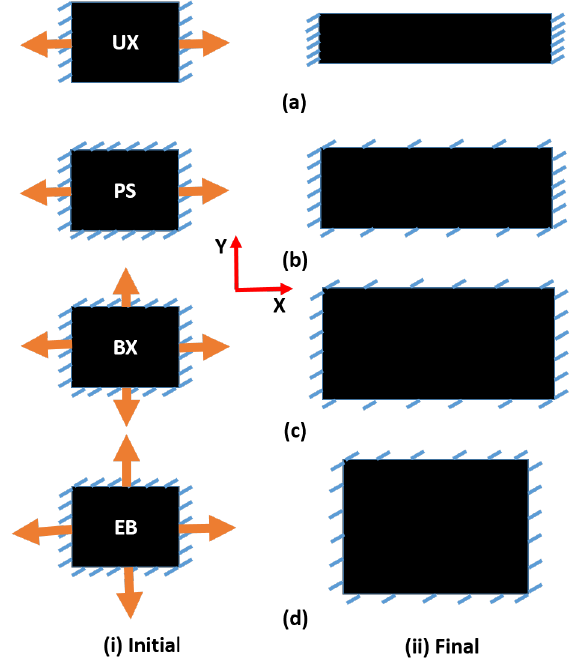
Figure 3. Representation of multi axial deformation modes at the ( i ) initial and ( ii ) final position of the specimen. The various deformation modes are shown in ( a ) UX ( b ) PS ( c ) BX and ( d )